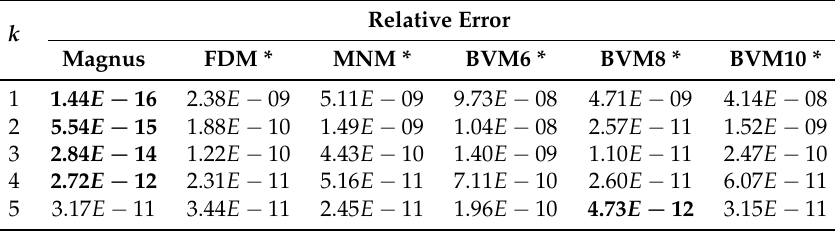
Table 5. The relative errors of the first five eigenvalues for y ( 4 ) + y = λ y , y ( 0 ) = y (cid:48)(cid:48) ( 0 ) = y ( 1 ) = y (cid:48)(cid:48) ( 1 ) = 0. Relative errors for all the methods except Magnus method are calculated from the eigenvalues reported in ([24], Table 5). * denotes the methods with correction terms. (Minimum relative error for each eigenvalue is in